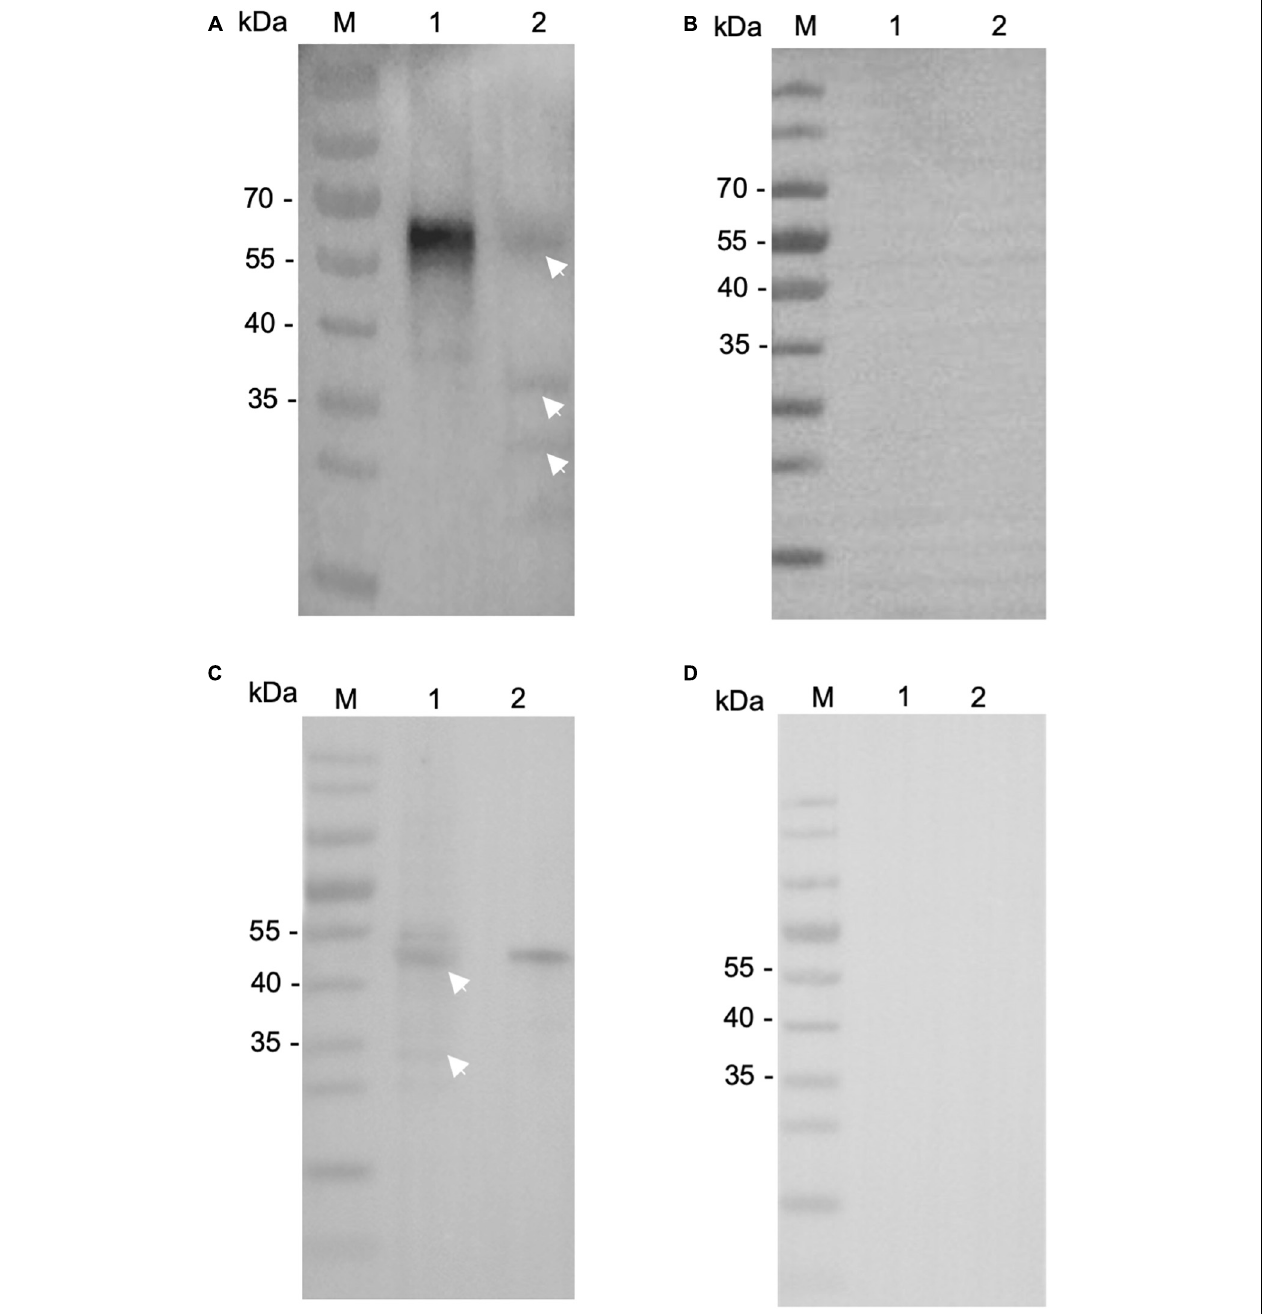
FIGURE 3 | Expression of native INS-21 and INS-23 proteins in sporozoites of Cryptosporidium parvum . Western blot analysis of native INS-21 protein using antibodies against INS-21 (A) and pre-immune serum (B) . Lane M, molecular weight markers; Lane 1, purified recombinant INS-21 protein; Lane 2, native proteins from sporozoites. Furthermore, the expression of native INS-23 protein was analyzed by Western blot using antibodies against INS-23 (C) and pre-immune serum (D) . Lane M, molecular weight markers; Lane 1, native proteins from sporozoites; Lane 2, purified recombinant INS-23 protein. Arrows indicate native proteins from sporozoites reacting with polyclonal